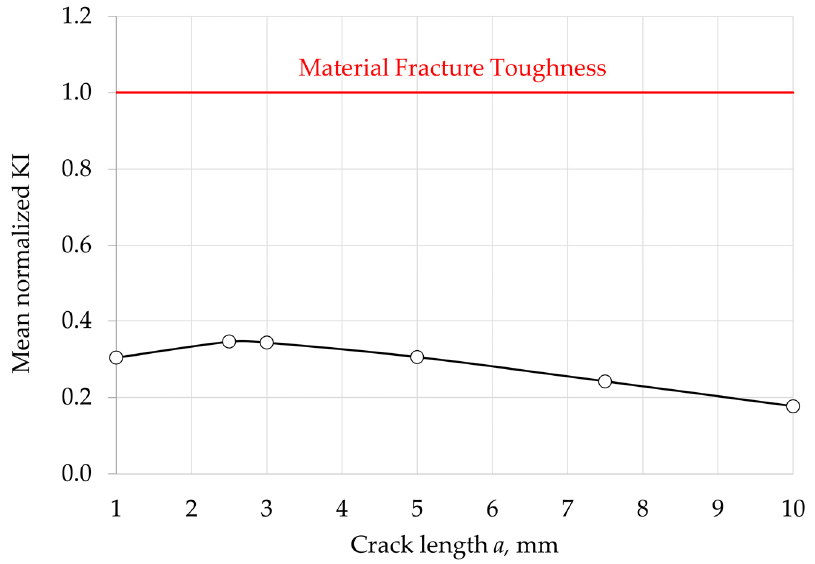
Figure 21. Evolution of K I with the crack length a at the PETE—normalized with the material fracture toughness.